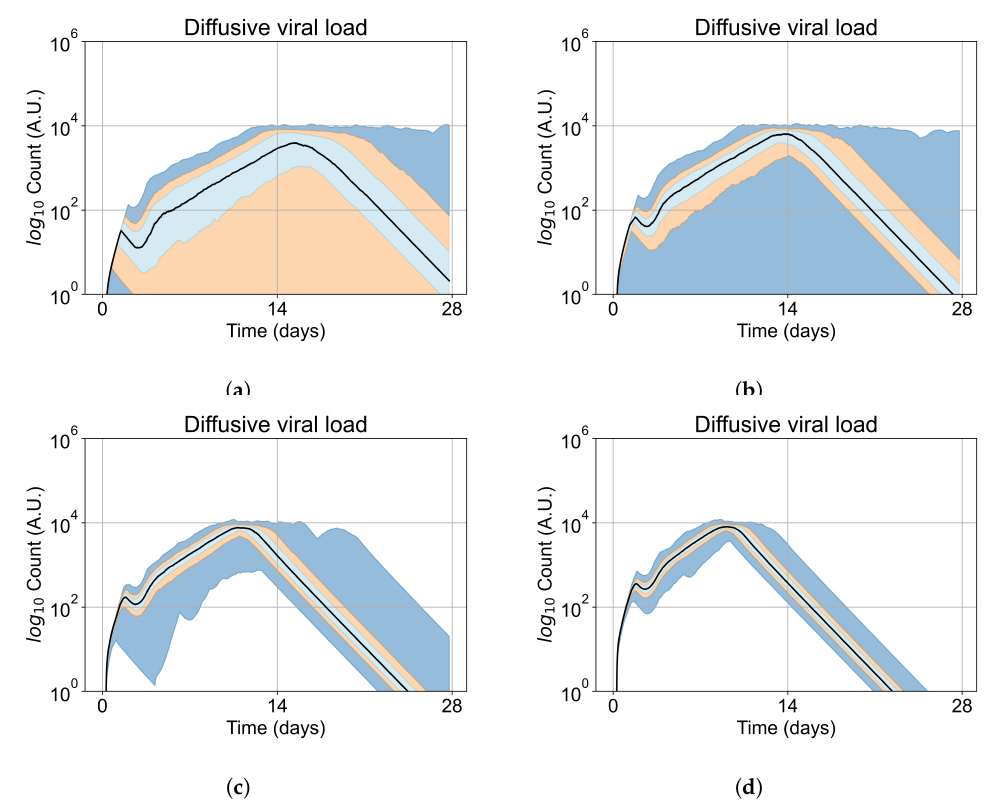
Figure A3. Extracellular viral load for 400 replicas of Sego et al.’s model [24], y-axis in log scale. In all the cases, the medians of simulation replicas are in black lines, the 0th to 100th quantiles are shaded as dark blue, 10th to 90th shaded in orange, and the 25th to 75th as light blue. ( a ) Simulations start with 1 initially infected cell and 7 simulations result in failure to infect (1.75% of replicas), the 90th quantile includes the upper bound of the number of cells. ( b ) Simulations start with 2 initially infected cells where 5 simulations result in failure to infect (1.25%), the 100th quantile includes the upper bound of the number of cells. ( c Simulations start with 5 initially infected cells. ( d ) Simulations start with 10 initially infected